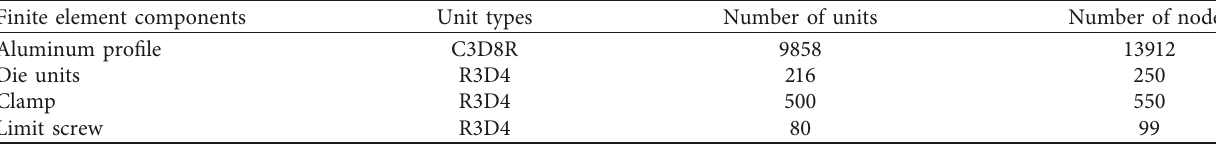
Table 2: Unit types and number of units and nodes for finite element components.